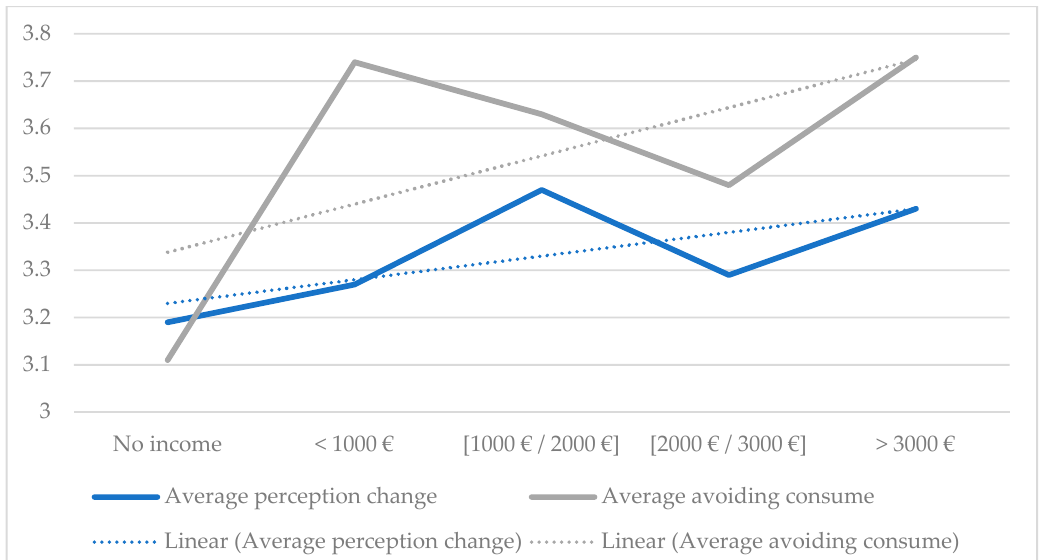
Figure 2. Summary of the responses to Question 2.